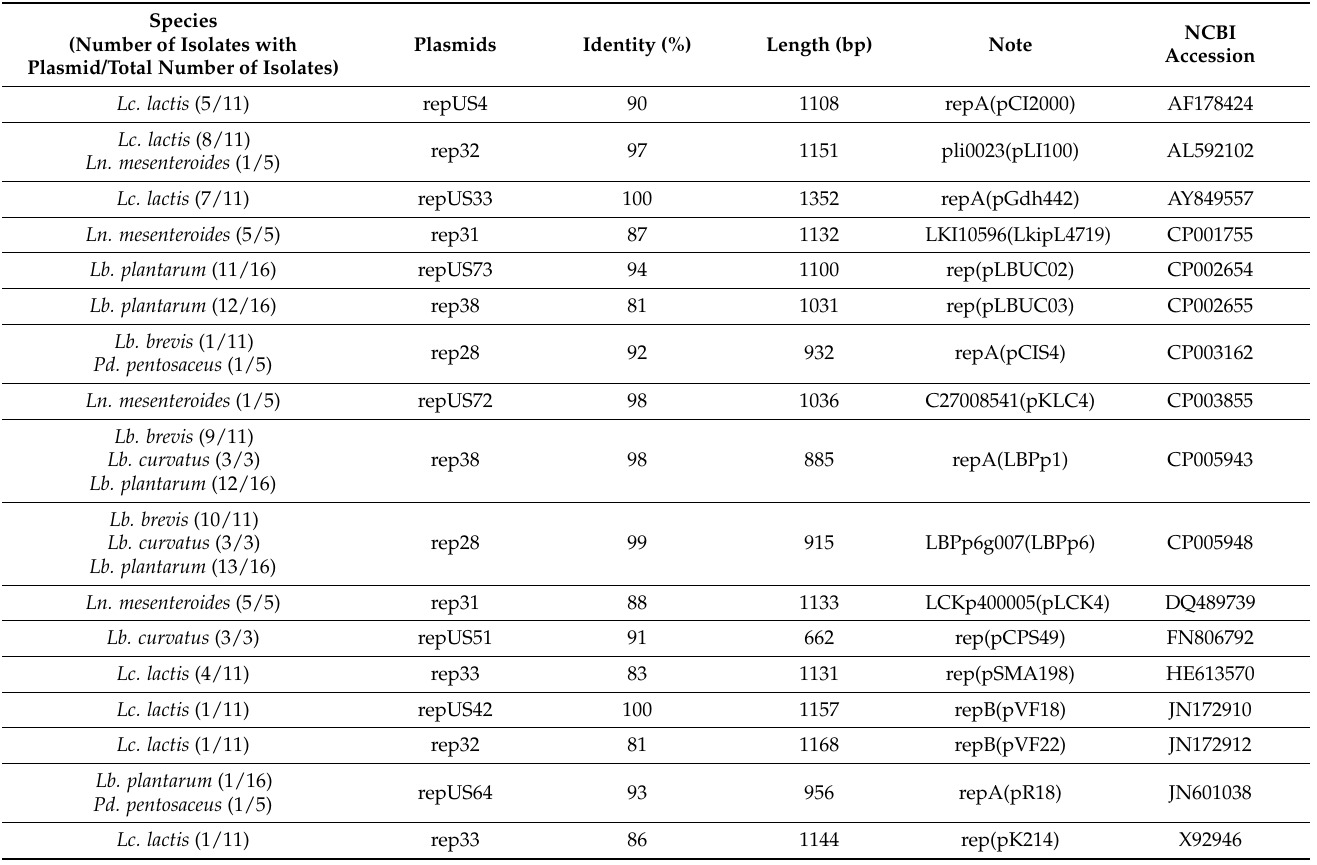
Table 2. Plasmids identified in LAB strains by the plasmidFinder tool. The number of isolates per species having a plasmid (based on the NCBI Accession column) is shown on the first